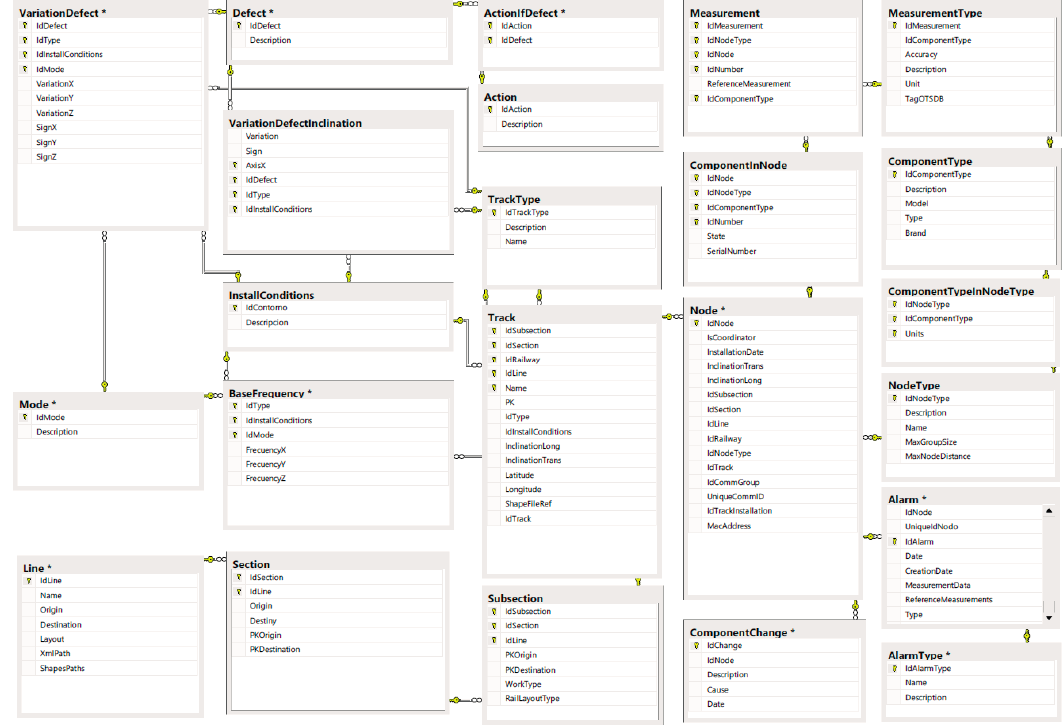
Figure 6. Database entity relationship